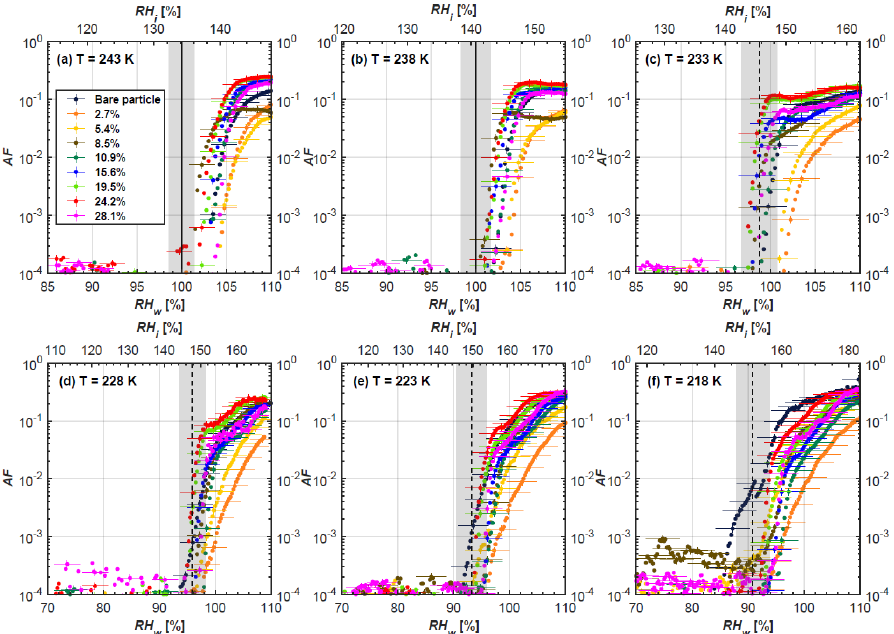
Figure B1. RH scans for bare and coated 200nm mCASTblack soot particles at eight different coating wt% corresponding to the 1µm OPC channel, presented as AF as a function of RH. Black solid lines represent water saturation conditions according to Murphy and Koop (2005). Black dashed lines denote the expected RH values for homogeneous freezing at T < HNT (Koop et al., 2000). The grey-shaded areas show the possible RH uncertainty calculated for water saturation and homogeneous freezing conditions. The percentage number represents the H 2 SO 4 coating mass ratio to the bare particle mass.